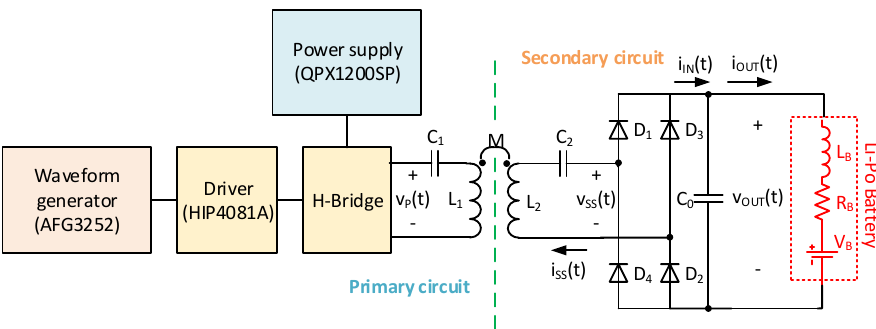
Figure 1. Schematic representation of the SS-ICPT architecture investigated in this